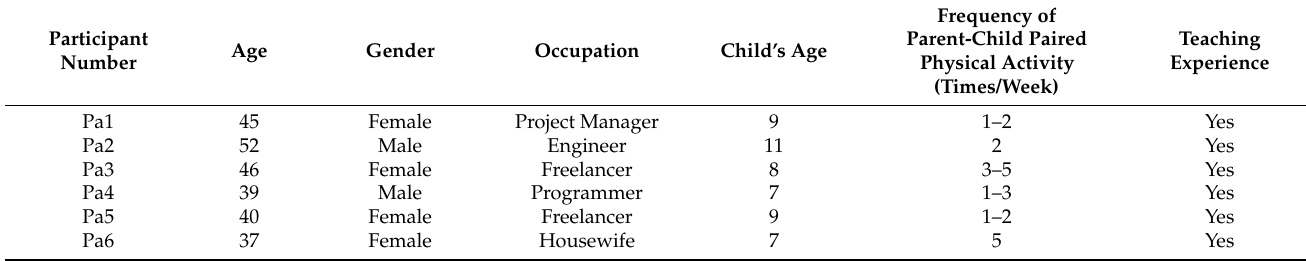
Table A2. Parents